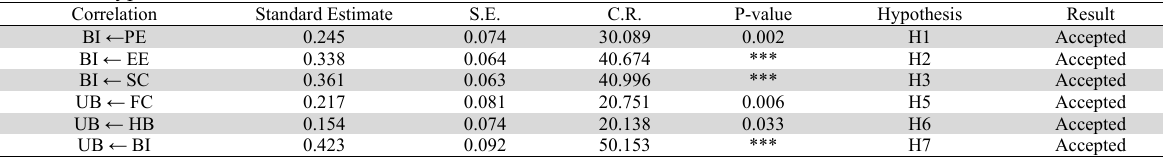
Results of hypothesis test